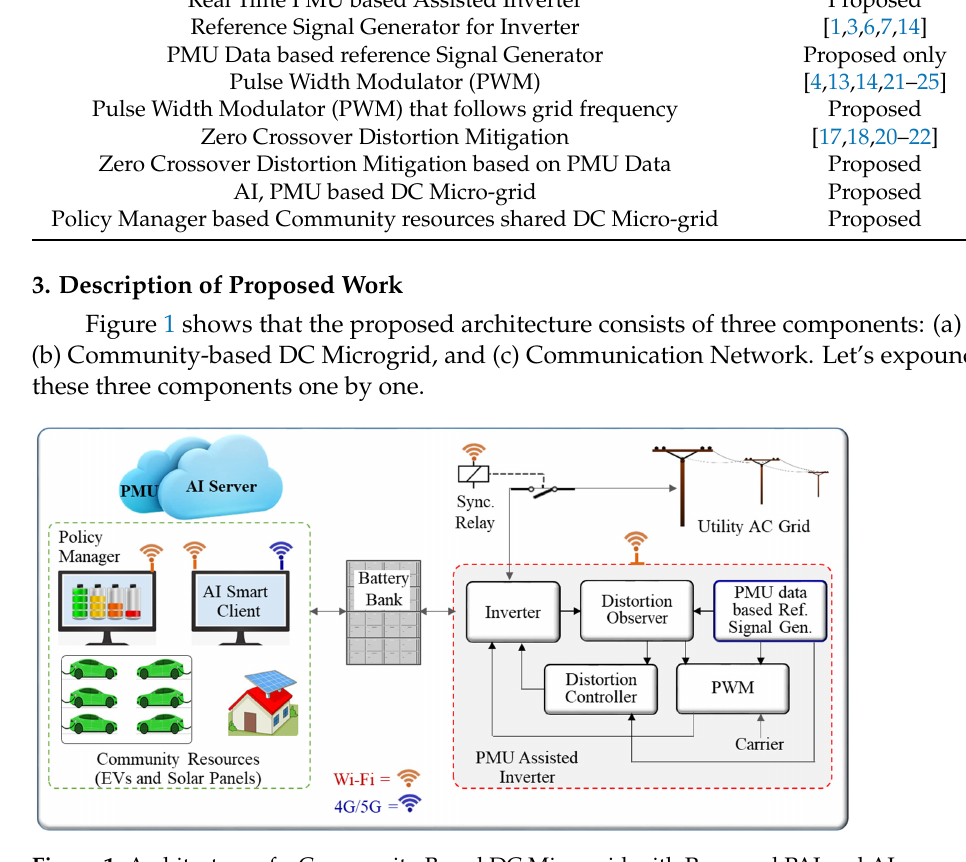
Figure 1. Architecture of a Community Based DC Microgrid with Proposed PAI and AI.